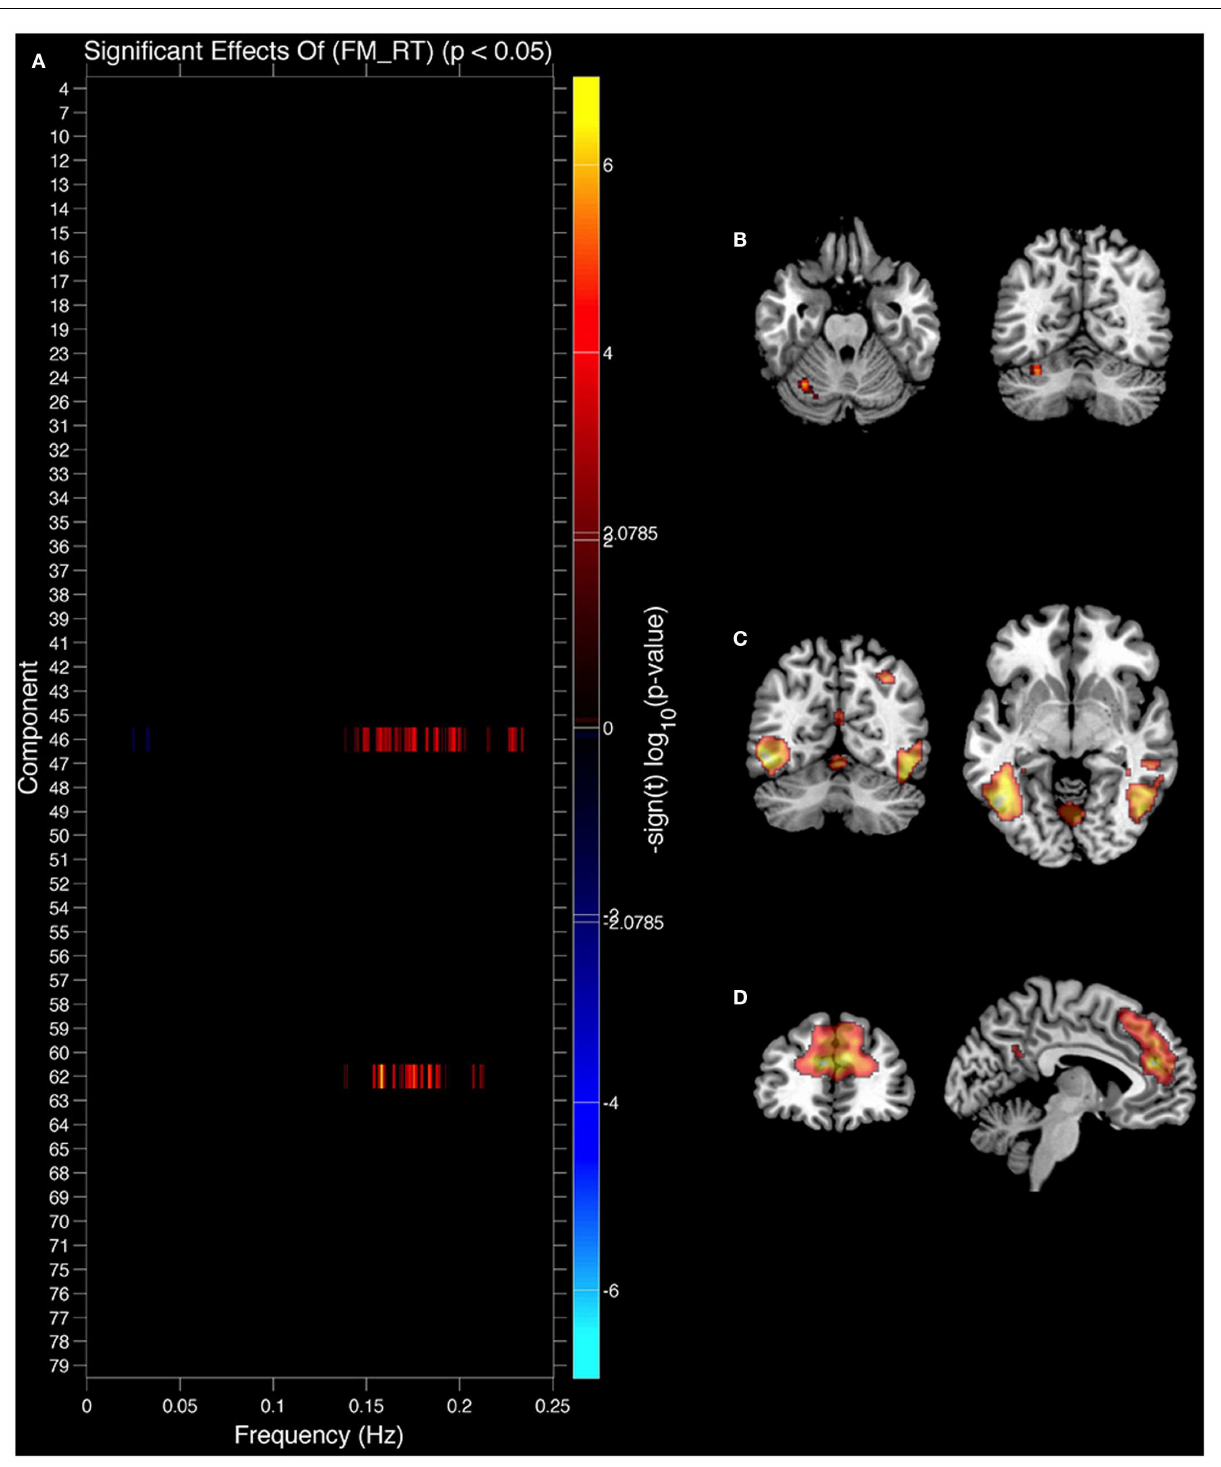
FIGURE 6 | Components showing a relationship between spectral power and face match reaction time (RT) . (A) Components where spectral power significantly covaried with face match RT. Red markers indicate a positive relationship (greater spectral power = slower RT), black indicates their was no